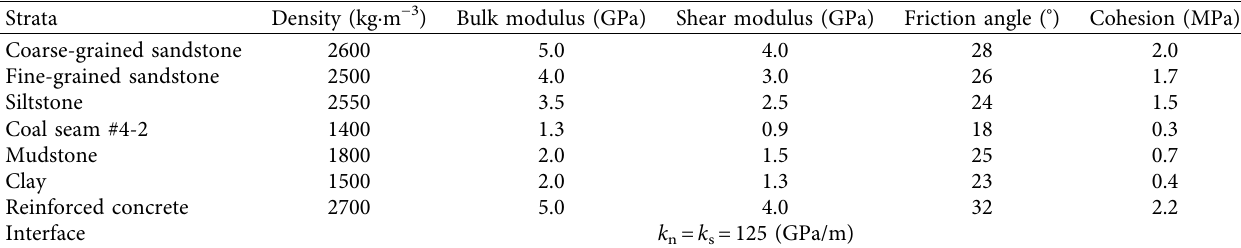
Table 1: Physical and mechanical parameters of surrounding rock and concrete.